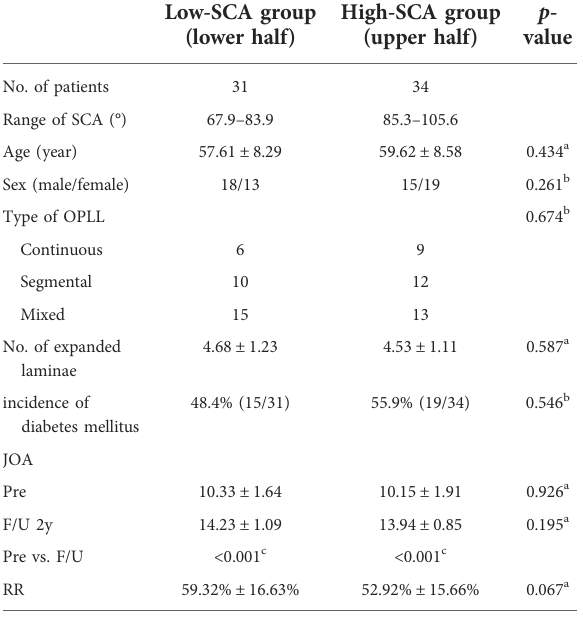
TABLE 1 Comparison of patient backgrounds according to preoperative